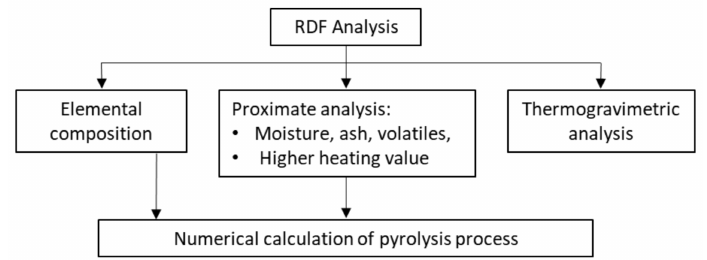
Figure 1. Flow chart of the study. Refuse derived fuel (RDF).